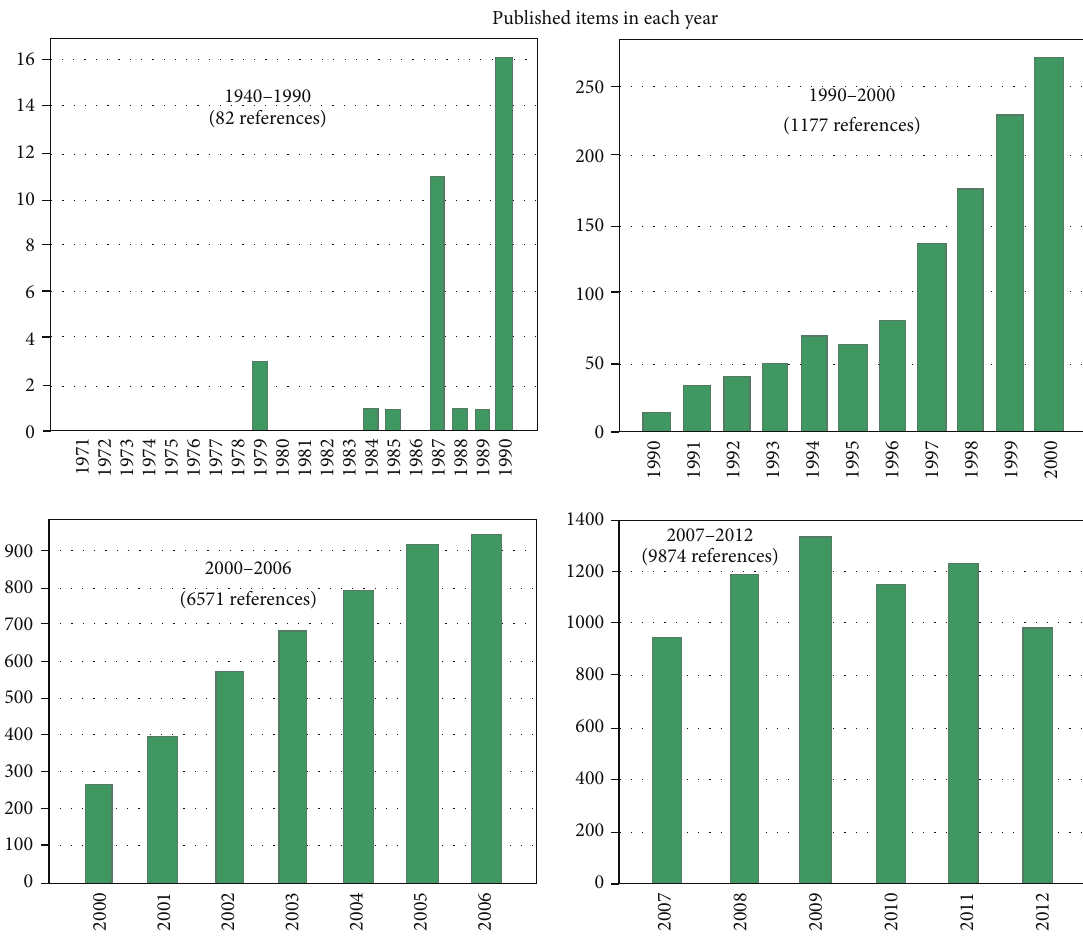
Figure 1: Web of Science timespan references